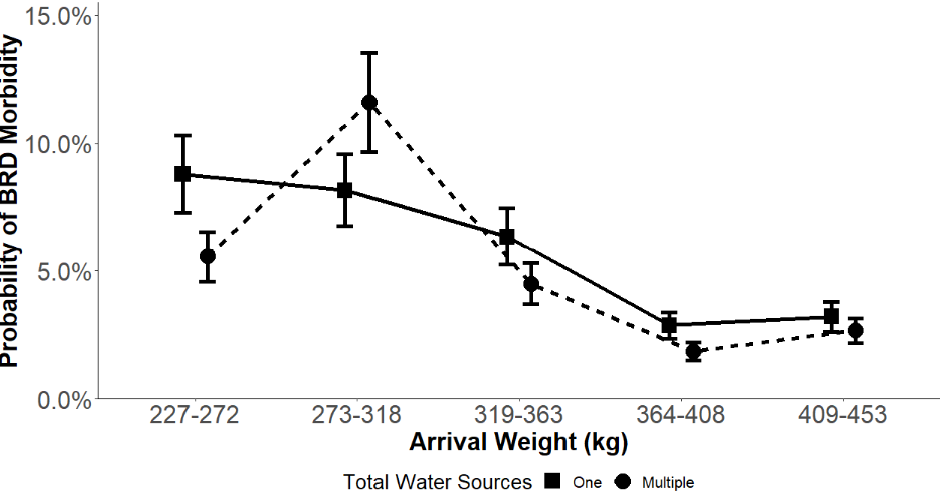
Figure 3. Model estimated mean probability of BRD incidence by total water sources and average arrival weight category in commercial feedlot cattle from 10 United States feedlots during the first 45 DOF using the NWmod *. Error bars represent SE of the probability. * NWmod is a generalized mixed model evaluating the number of water sources while including covariates for cohort sex, size at arrival, average arrival weight, arrival quarter and significant interactions.